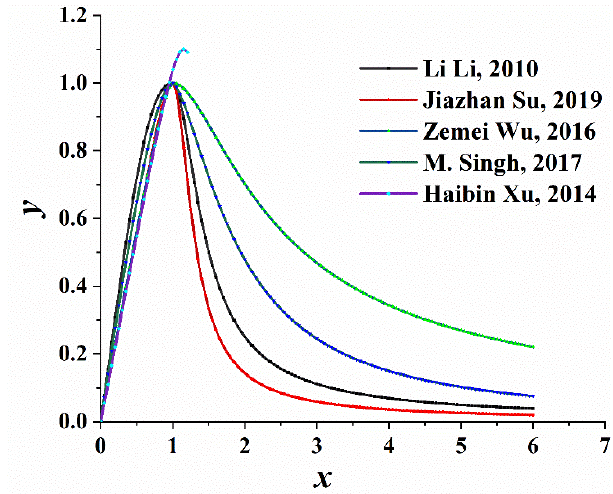
Figure 2. Uniaxial compressive stress-strain curve.